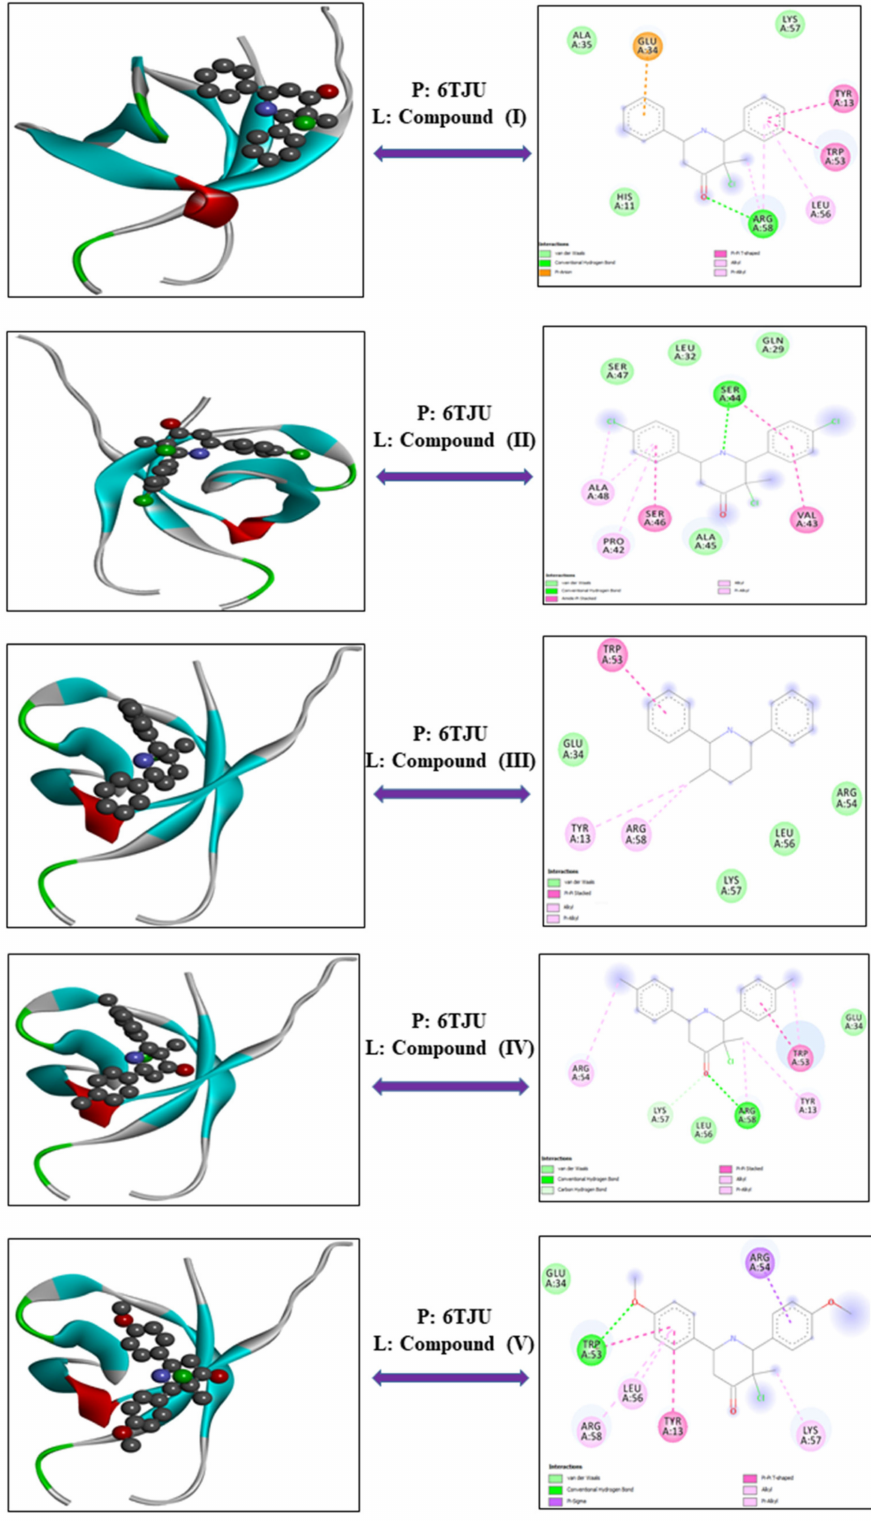
Figure 3. Compounds I – V (ligands) and 6TJU (protein) are all best-docked positions, and the right side shows the lowest-energy 2D